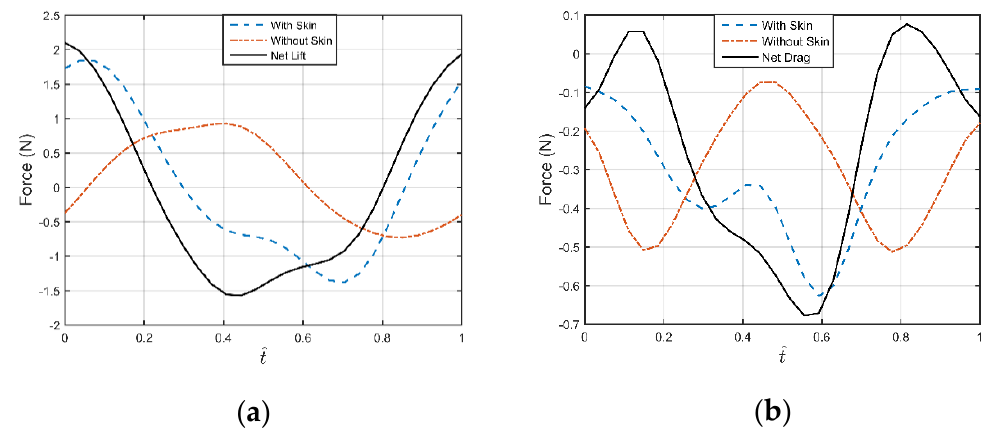
Figure 12. The aerodynamic lift ( a ) and drag (or thrust), ( b ) extracted from the experimental data.